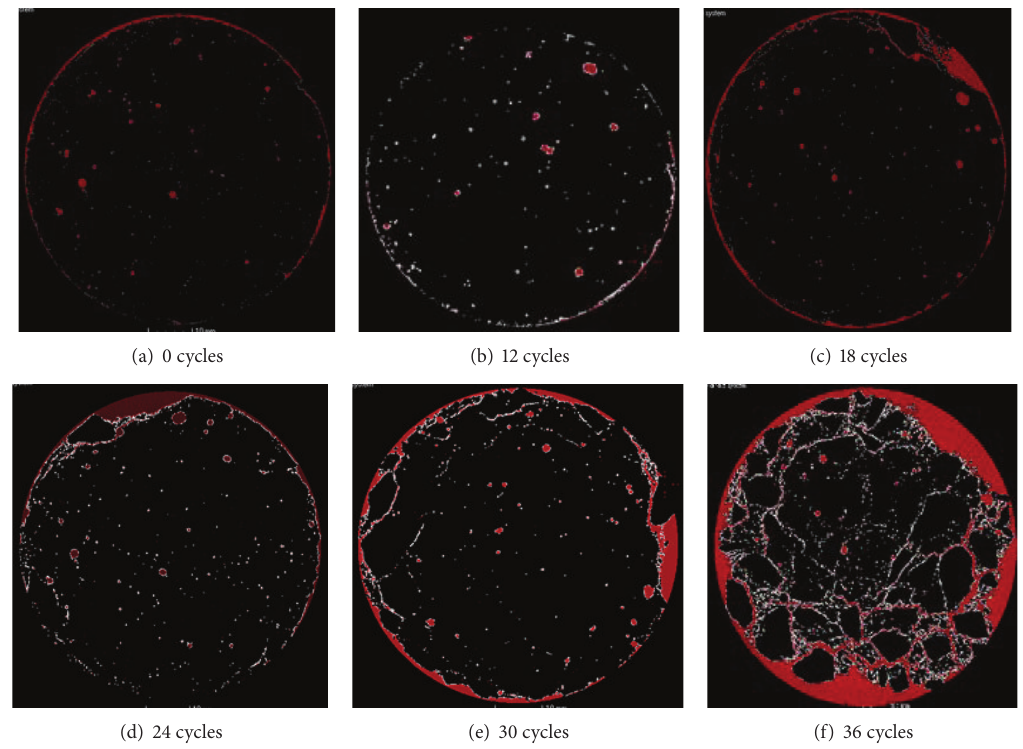
Figure 12: Damage process of the middle section under different cycles of